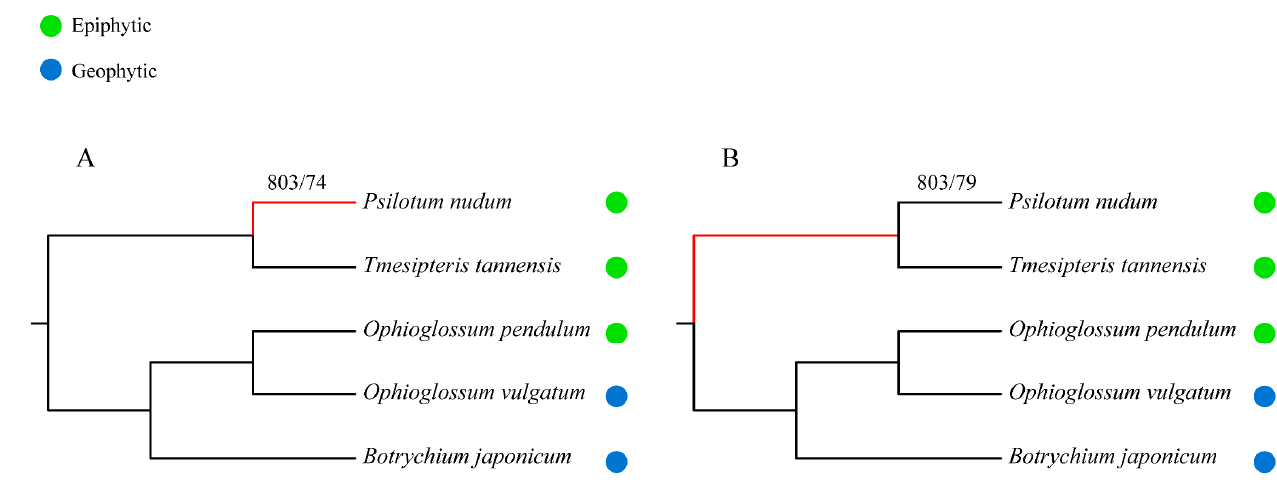
Figure 5. The phylogenetic relationships of whisk ferns and ophioglossoid ferns used to detect genes under positive selection. ( A ) Selection pressure analysis where Psilotum nudum was labeled as the foreground. ( B ) Selection pressure analysis where the common ancestral branch of whisk ferns was labeled as the foreground. Branches in red color indicate foreground branches for detection of genes under positive selection. The color of the circle represents the ecological habit of each species, with green for epiphytic habit and blue for geophytic habit.